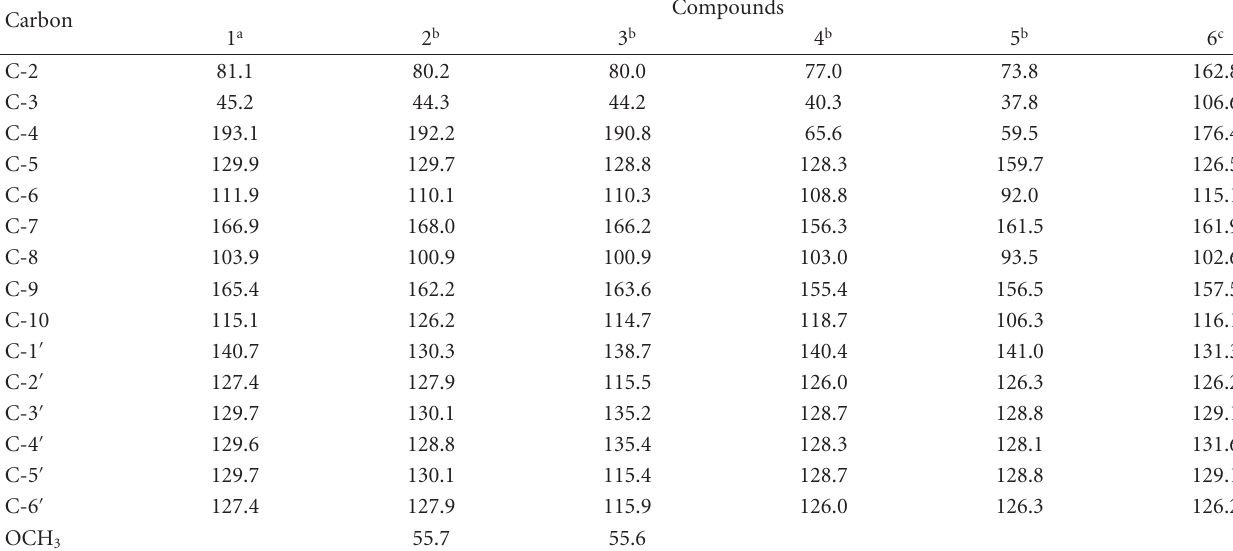
Table 2: 13 C NMR chemical shifts ( δ ) of compounds 1 ÷ 6